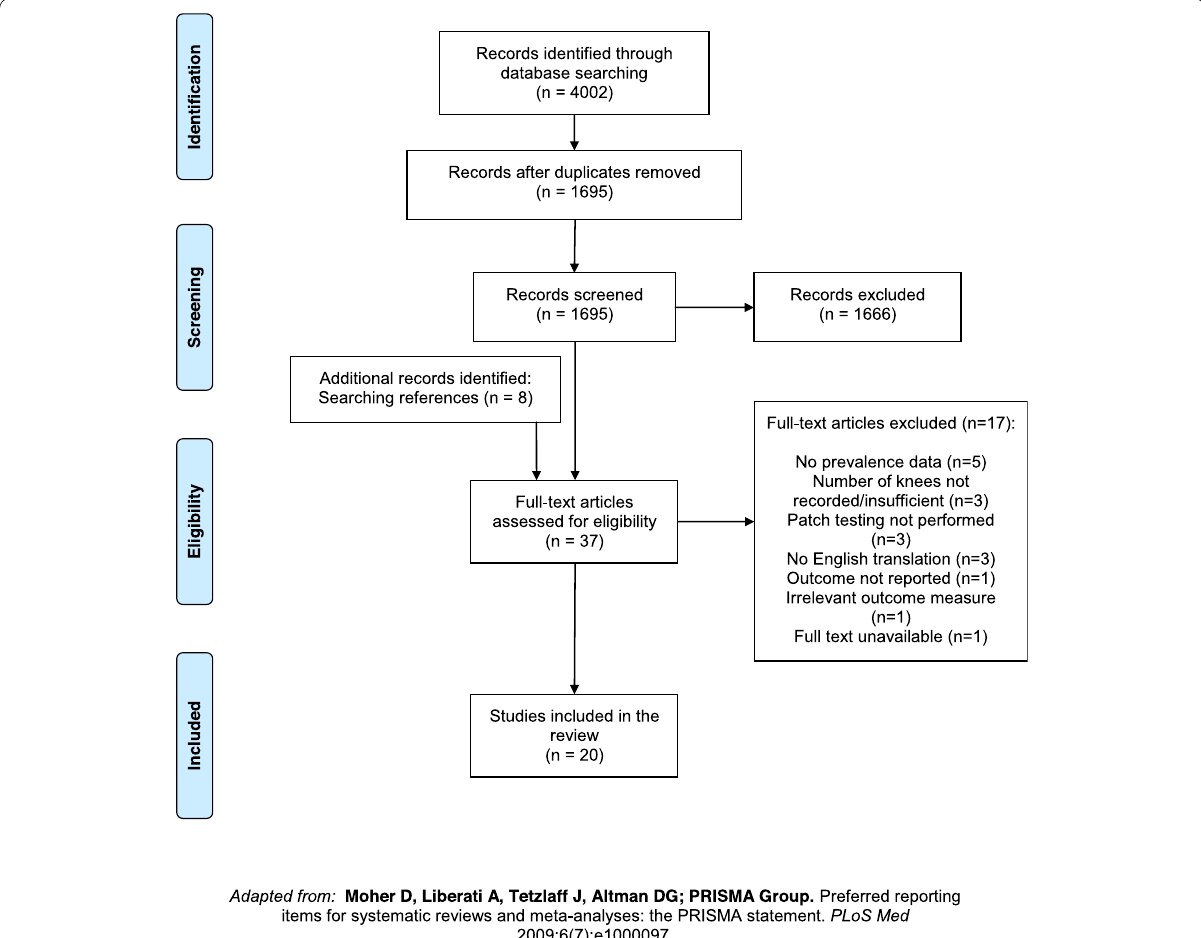
Fig. 1 PRISMA flow diagram for search